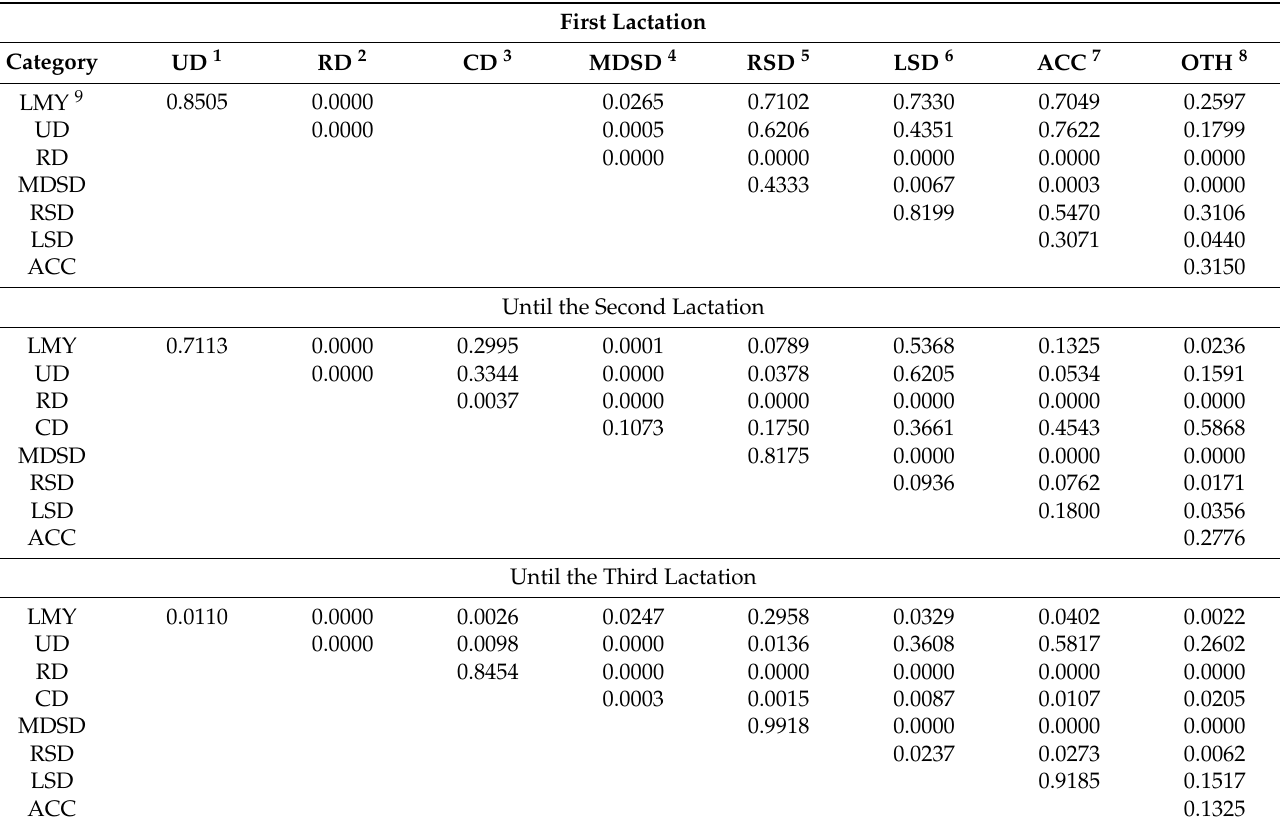
Table 3. p -values for comparisons between survival curves for cows from individual culling categories. First